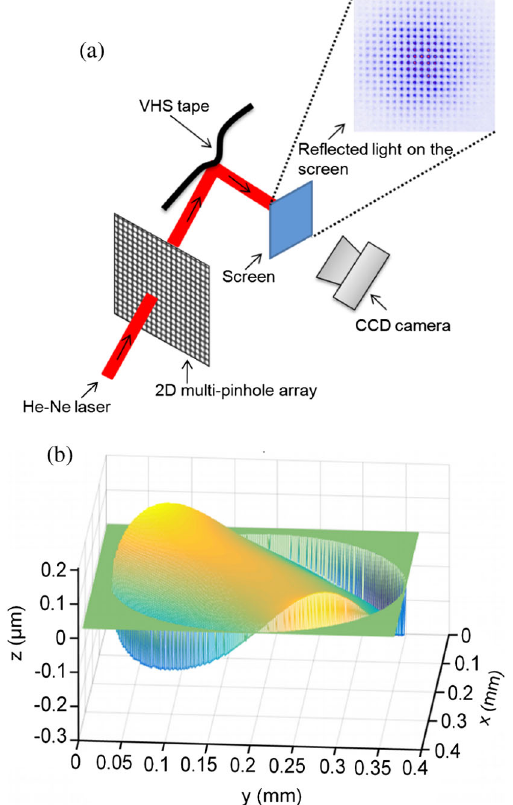
FIG. 3. Targeted area surface monitoring. (a) Schematic of the setup consisting of He-Ne laser with a multipinhole array and a CCD camera, (b) 3D plot of the reconstructed surface of the targeted area using Zernike polynomials.